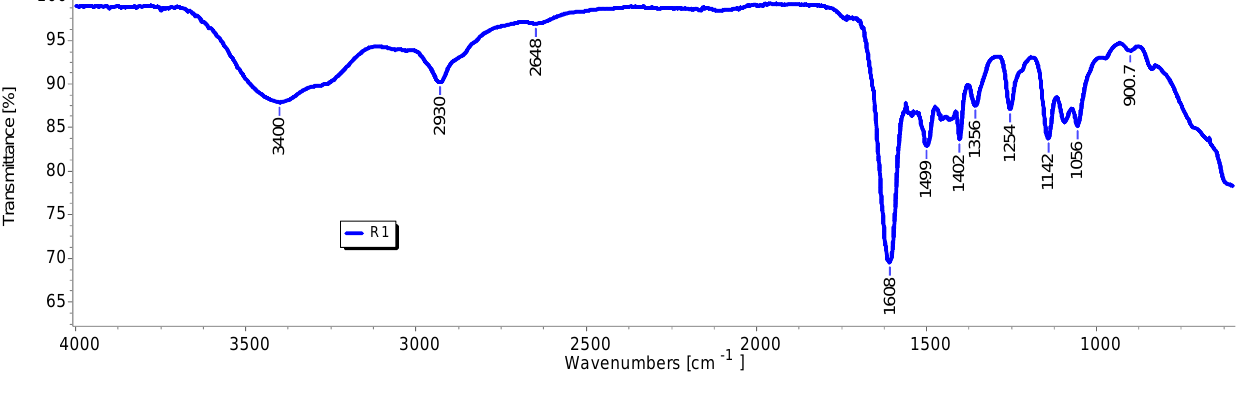
Figure 5. ATR-FTIR spectrum of R1.